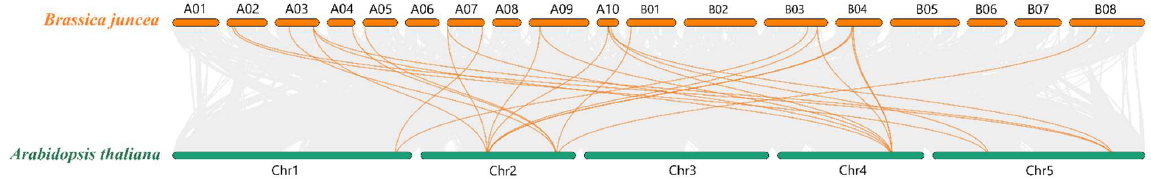
Figure 3. Collinearity analysis of CKX gene family between B. juncea and A. thaliana . The colored round rectangles represent the chromosomes of two plants. The gray curves connect protein-coding genes in the synteny blocks, and the orange curves represent gene pairs that are collinear with UBC genes in B. juncea / A. thaliana .